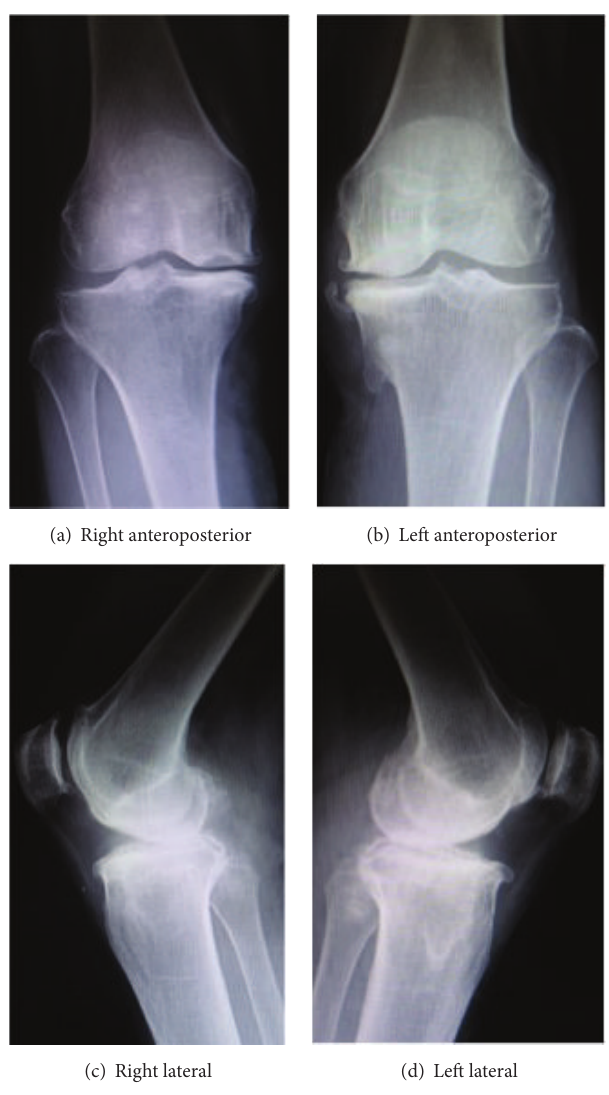
Figure 1: Preoperative X-ray.